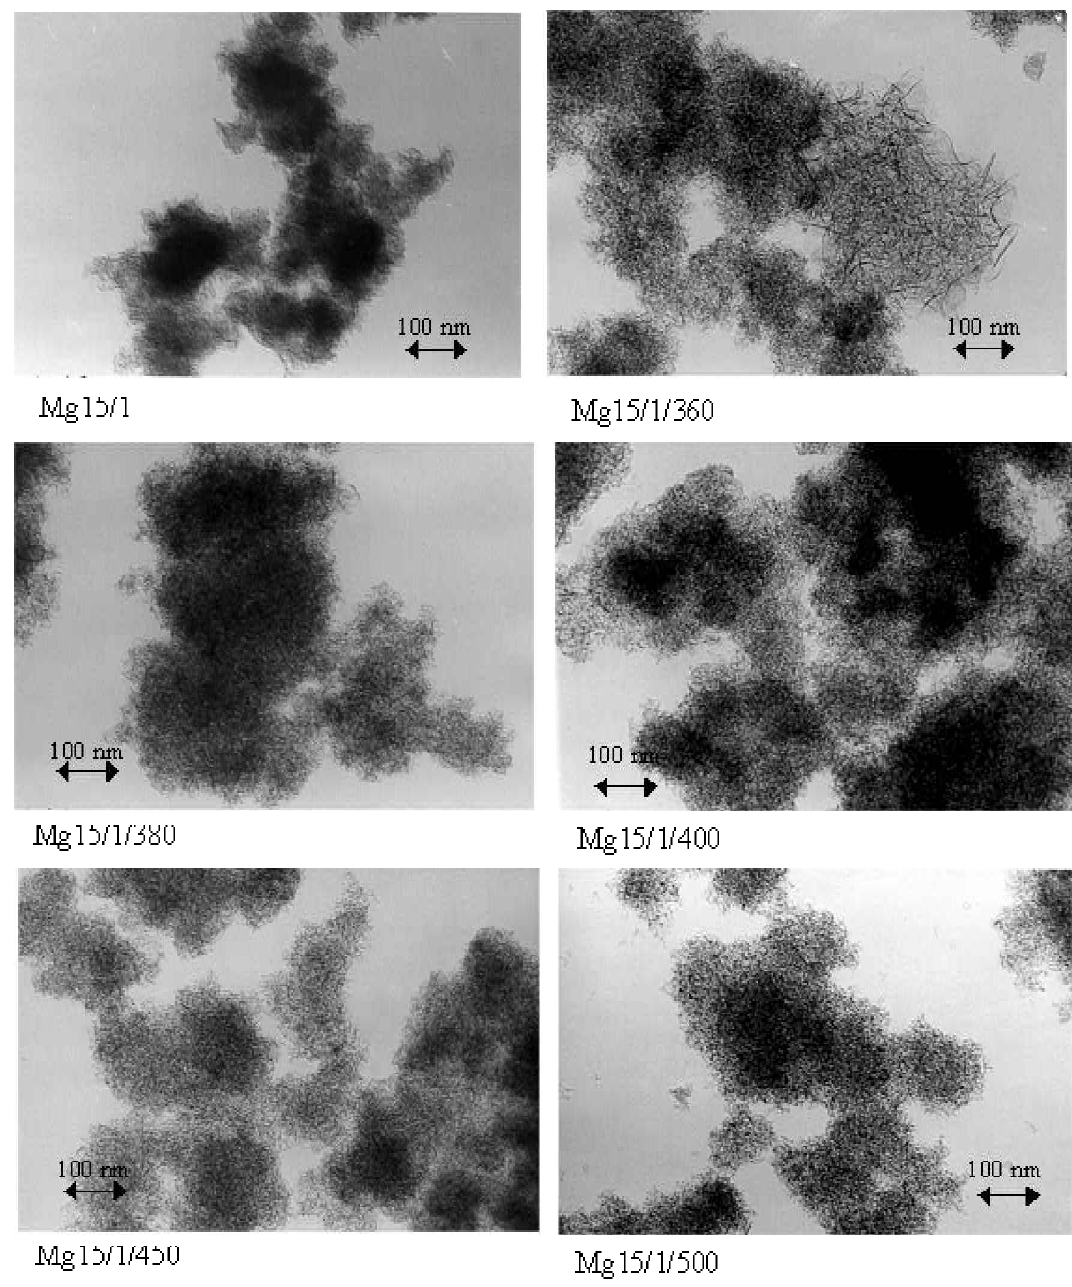
Fig. 3 TEM micrographs of precursor Mg15 and heated samples